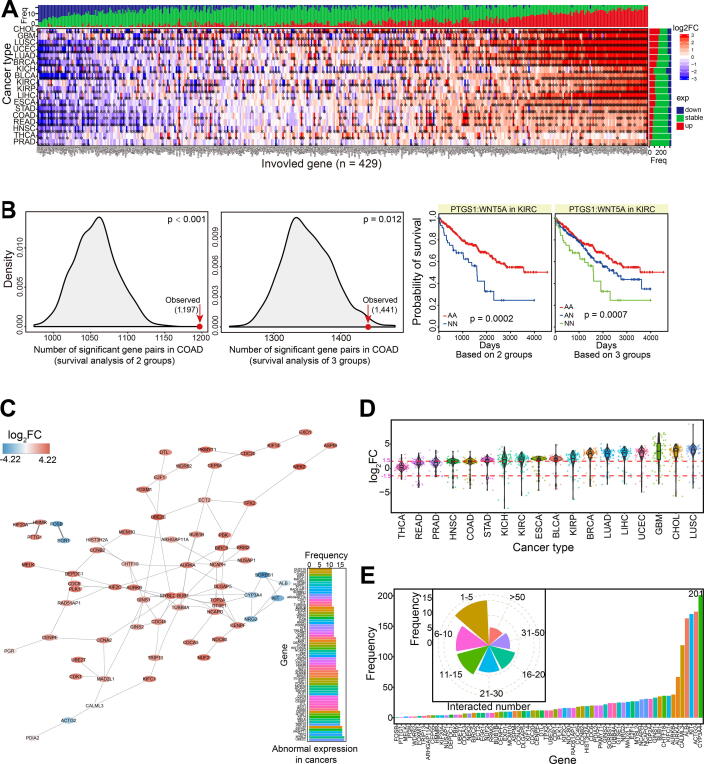
Analysis of synthetic lethal interactions at gene expression level. A. Expression distributions for screened abnormal genes across diverse cancer types. * indicates significantly deregulated gene with |log2FC| >1.50 and padj < 0.05. B. Survival analysis of different groups based on expression patterns. The observed number of significant gene pairs is compared with a randomization test in COAD (1000 times). The empirical p-value based on the two groups is 0.000, and the empirical p-value based on the three groups is 0.012. An example shows probability of survival for PTGS1:WNT5A gene pair in KIRC based on 2 (AA, n = 314; NN, n = 47) and 3 groups (AA, n = 314; AN, n = 169; NN, n = 47), respectively. AA: both deregulated in candidate gene pair; AN: one abnormally and another normally expressed; NN: both normally expressed genes. C. An interaction network for screened 68 abnormally expressed genes. The deregulated expression pattern is derived from BRCA as an example to present their expression trends. D. Expression patterns of these 68 genes across diverse cancer types. The specific values of log2FC, 1.50 and −1.50 are presented as the cutoff values. E. The detailed distributions of interacted numbers with other genes based on the whole candidate gene pairs. The main pie distributions based on several classes of interactions are also presented.